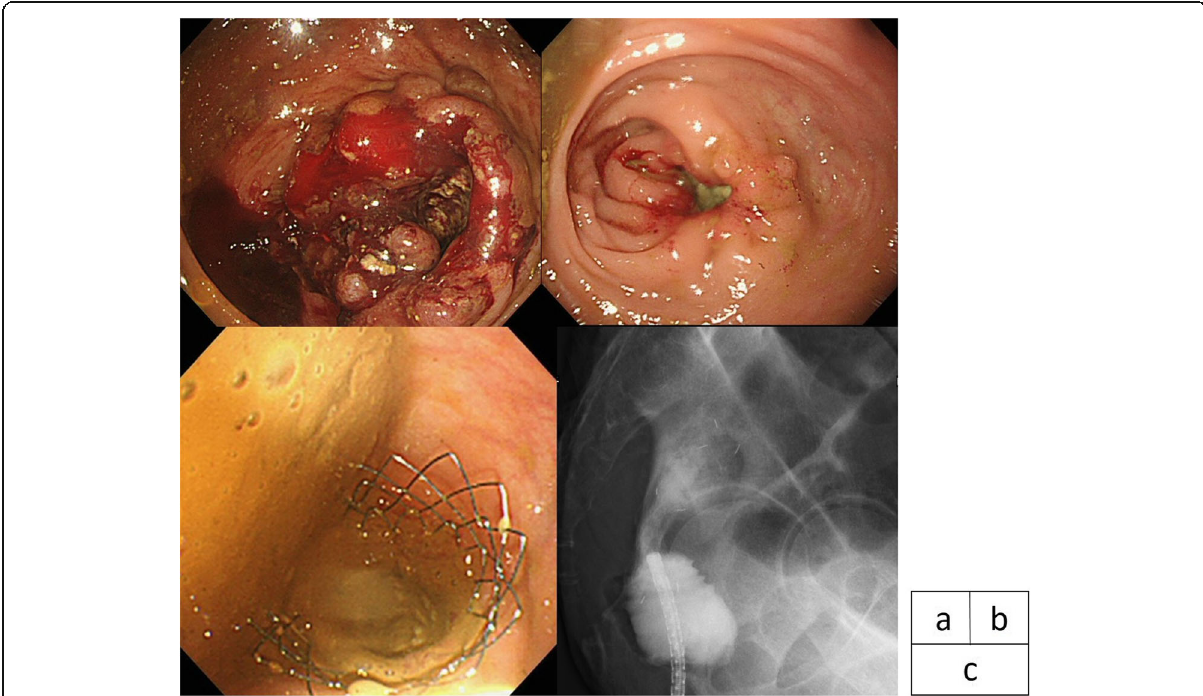
Fig. 1 a Colonoscopy findings. Colonoscopic examination revealed a circumferential tumor in the lower rectum, 60 mm from the anal verge. b Colonoscopy findings. Colonoscopic examination showed smooth stenosis with growth of fibrous tissue that seemed to have been caused by a good response to NAT. c Stent placement. A Niti-S Colonic Stent, 8 cm in length by 18 mm in diameter, was placed across the obstruction as a